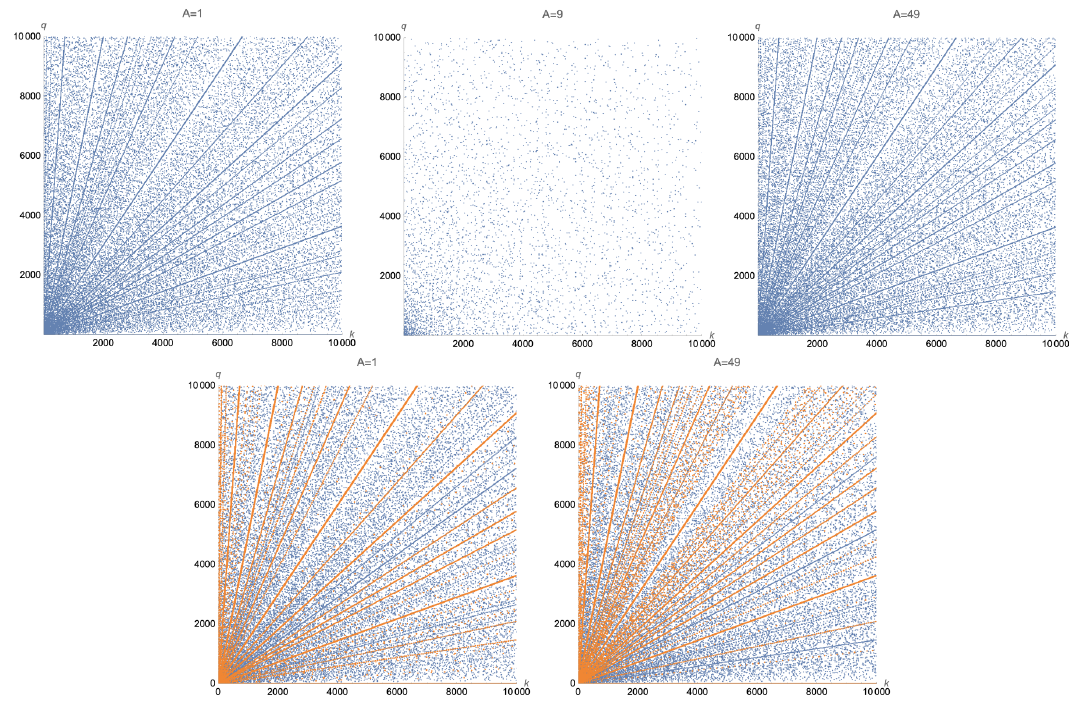
Figure 3 . In the first row of figures, the blue points give integer solutions to (4.26) for the special values A = 1 , 9 , 49 . In the second row, we superpose these plots with orange lines corresponding to analytical solutions to the Pell equation (4.28) as discussed in the